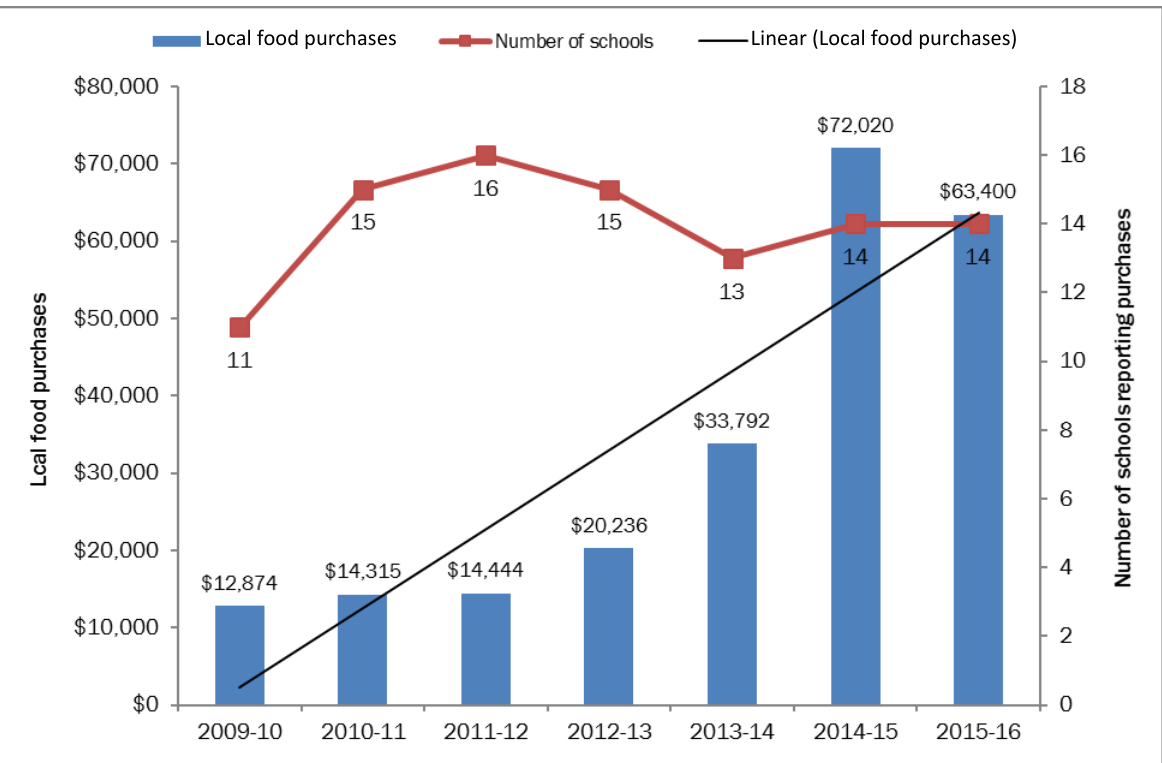
Figure 3. Northeast Iowa School Purchases of Local Foods Showing the Increase from the